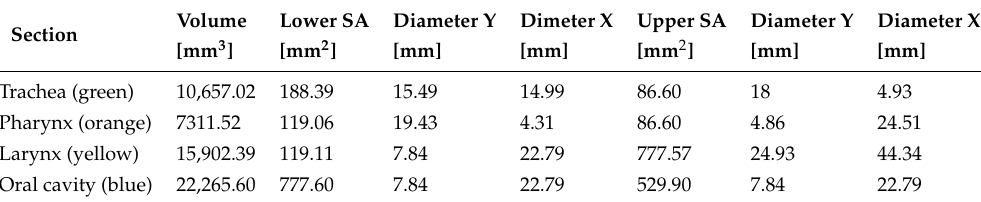
Table 1. Summary of the mechanical UAM dimensions of a 28-year-old, healthy, nonsmoking, male. The sections correspond to the highlighted sections in Figure 2. SA—surface area.